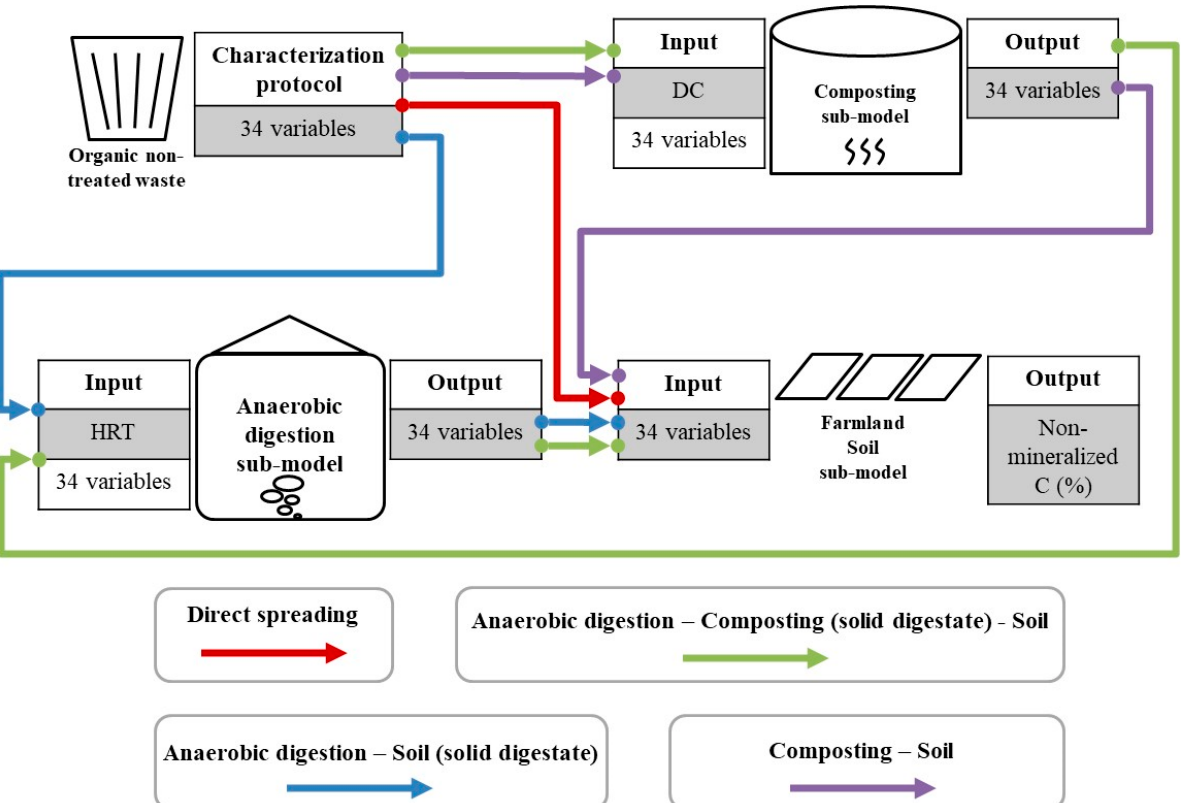
Figure 1. Schema of the concept of modeling. AD − anaerobic digestion; HRT − hydraulic retention time (days); DC − duration of composting (days).